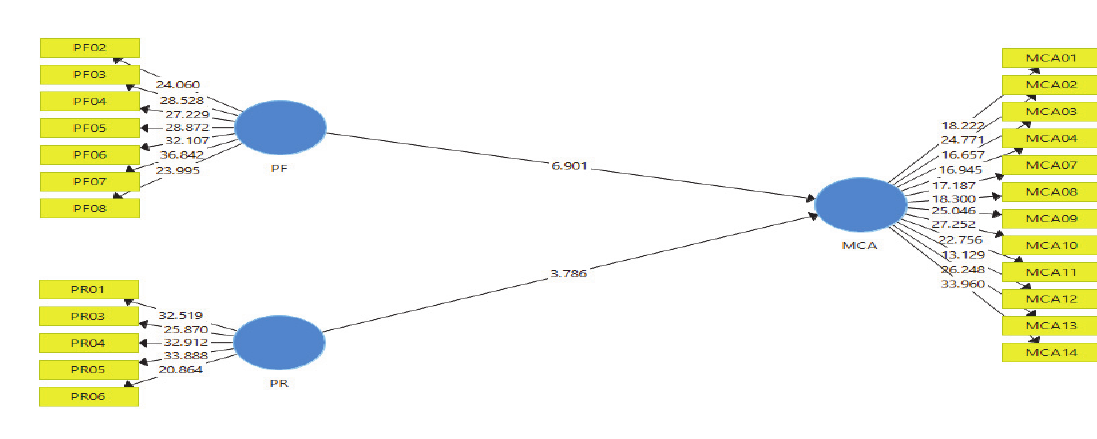
Fig. 4. Structural